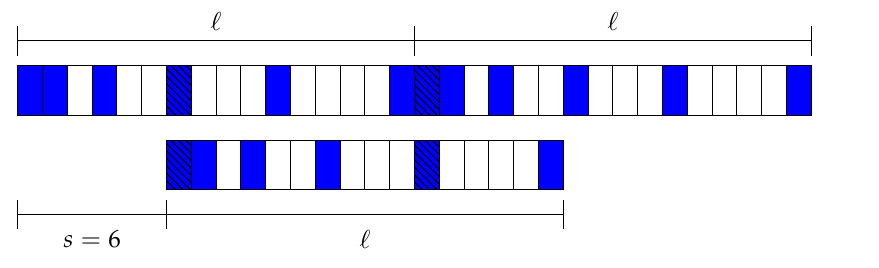
Figure 4. Example for the c ( s ) function.